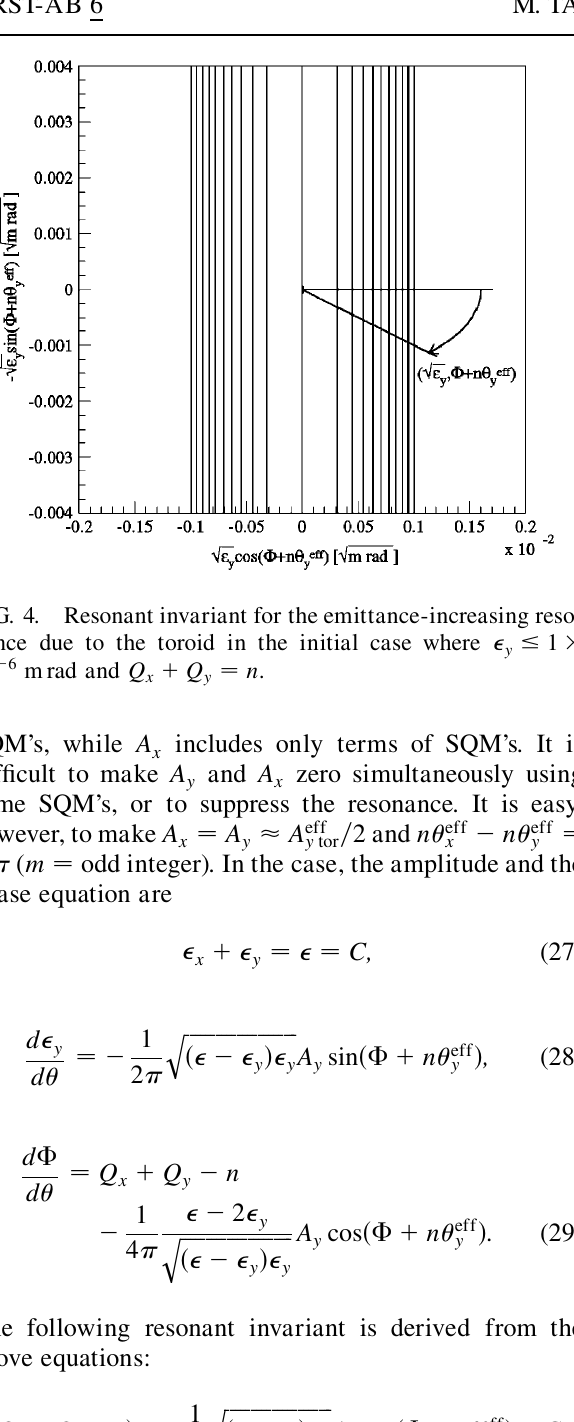
FIG. 6. Incoherent betatron-tune distribution just before the transverse instability (at 28 ms in Fig. 1).